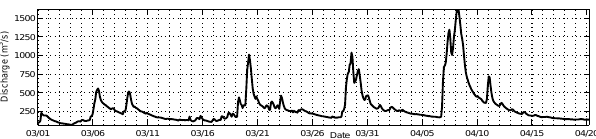
Fig. 4. Instantaneous discharge of Piura River measured at Puente ˜N´acara in 2002. Time is LT.